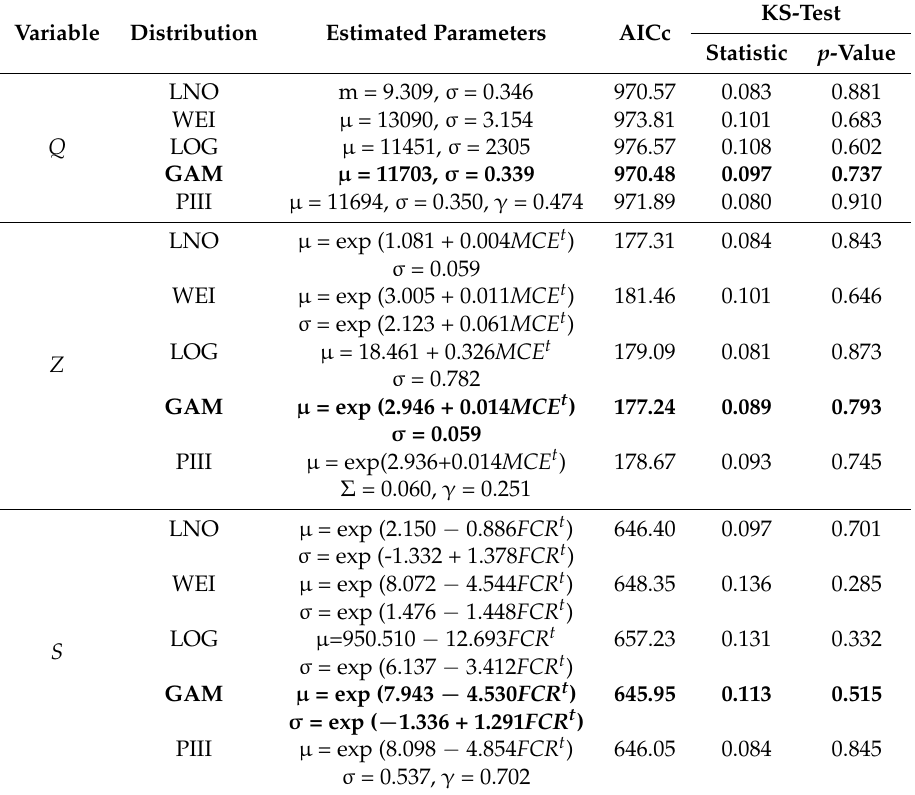
Table 3. Parameters and goodness-of-fit of the candidate marginal distributions fitted to Q , Z , and S at the Waizhou station during 1964–2013,